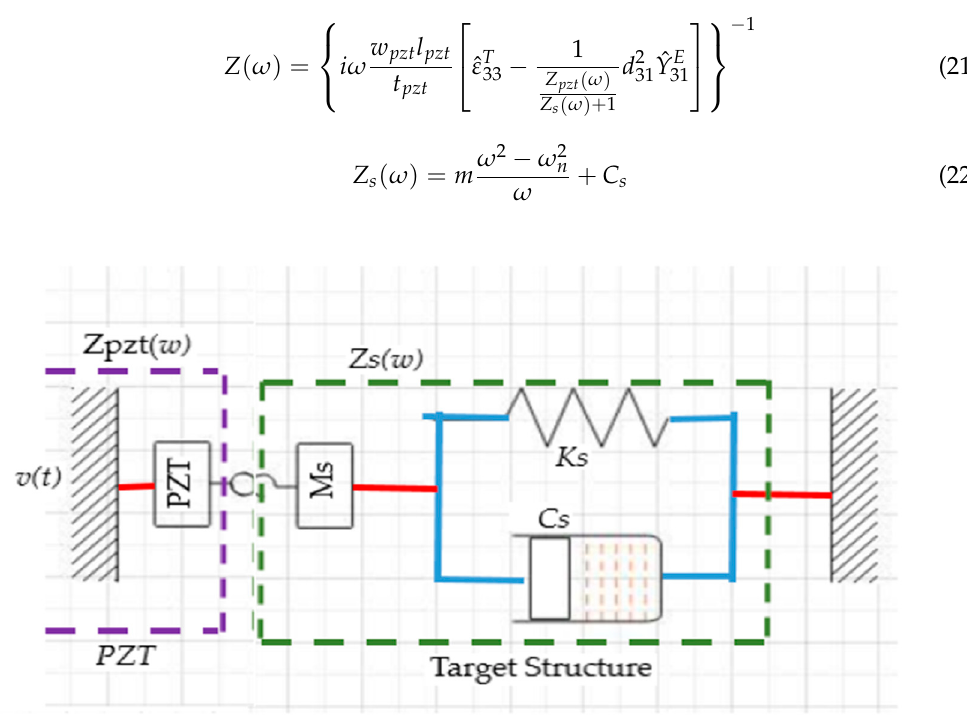
Figure 14. 1-D PZT–target structure interface [143].